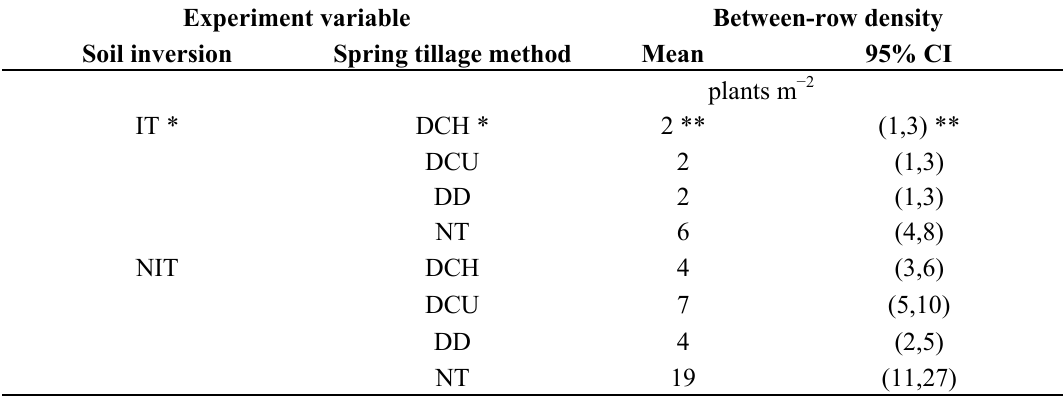
Table 3. Soil inversion by spring tillage method interaction means for between-row Palmer amaranth density at 6 WAP *; data combined over cover crops and production